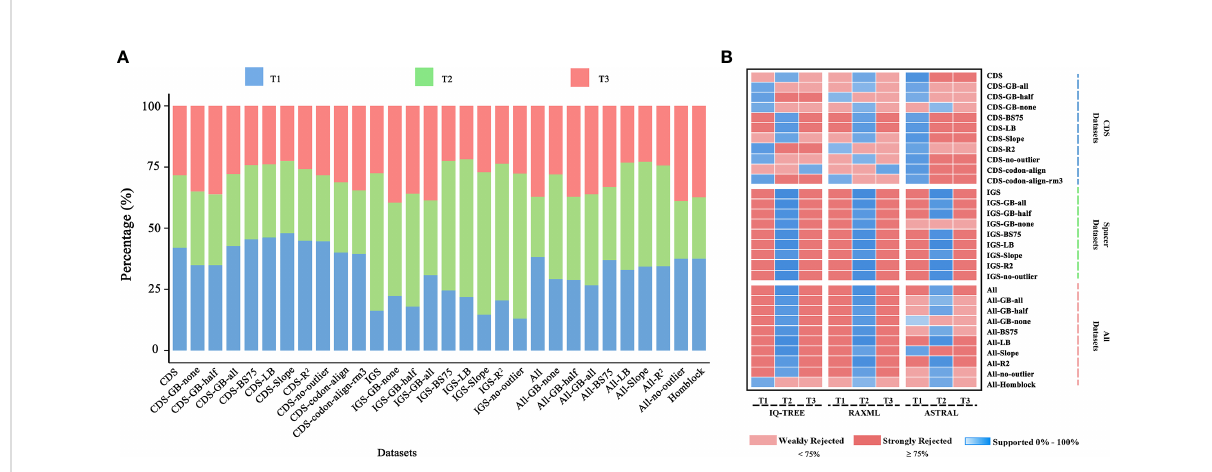
FIGURE 7 (A) Percentage of loci supporting each of the three alternative topological hypotheses across the 30 datasets, based on gene-wise likelihood scores; (B) Meta-analysis of species trees. Blue indicates the topology inferred from the dataset, and shades show the level of ultrafast